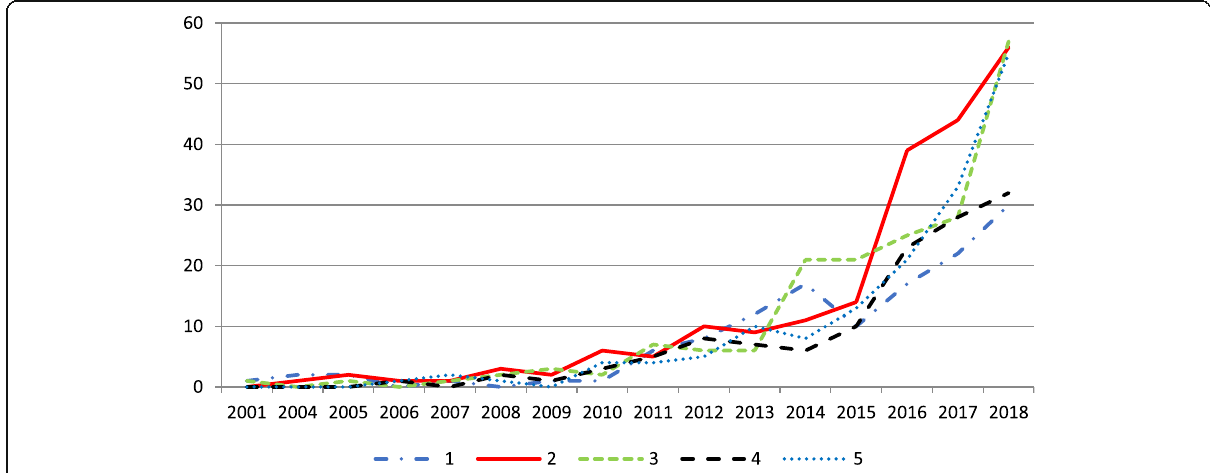
Fig. 9 Publication distribution with single or different joint authorship over the years. (Note: 1=single author; 2=two co-authors; 3=three co- authors; 4=four co-authors; 5=five or more